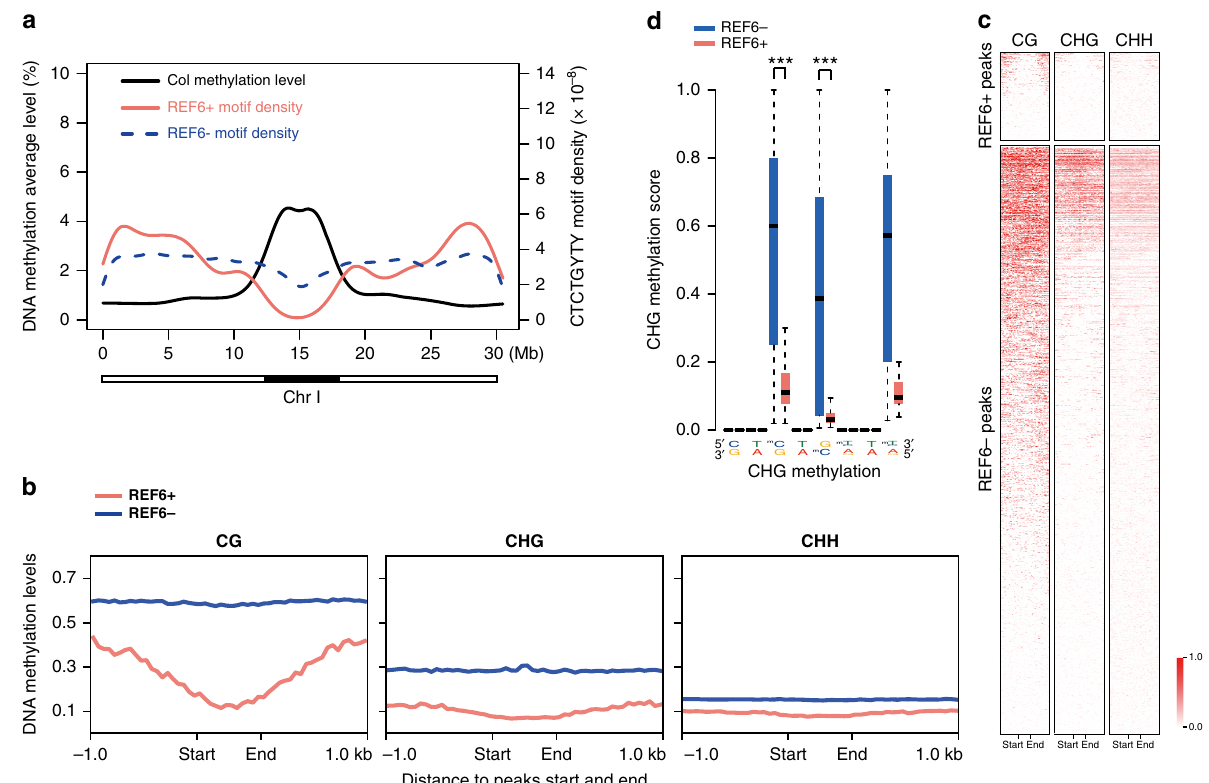
Fig. 1 REF6 prefers to bind DNA hypo-methylated regions. a DNA methylation level, as well as REF6 bound and unbound motif density, on Chromosome I. The black bar below the panel shows the position of heterochromatin. b Average distribution of DNA methylation levels (CG, CHG, CHH) over central regions within REF6-bound (REF6 + ) and REF6-unbound (REF6 − ) motifs; peak “ start ” and “ end ” sites are separated by 600 bp. REF6 − regions were constructed as described in “ Methods ” . c Heatmap of DNA methylation levels within REF6-bound and REF6-unbound regions. d CHG methylation levels at CTCTGYTY motifs in REF6-bound (REF6 + ) and unbound (REF6 − ) regions. The box plots display the median (center line) and interquartile range (IQR; from the 25th to 75th percentile), and the whiskers represent the minimum and maximum of DNA methylation score from 0 to 1. Mann – Whitney U -test was used to calculate the P -value. *** P < direct evidence supporting REF6 prefer to bind hypomethylated DNA in the Arabidopsis genome.